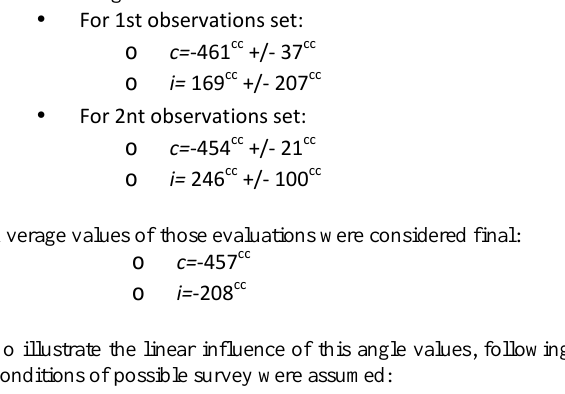
Figure 5. The angles between the positions of the scanner in the tribrach